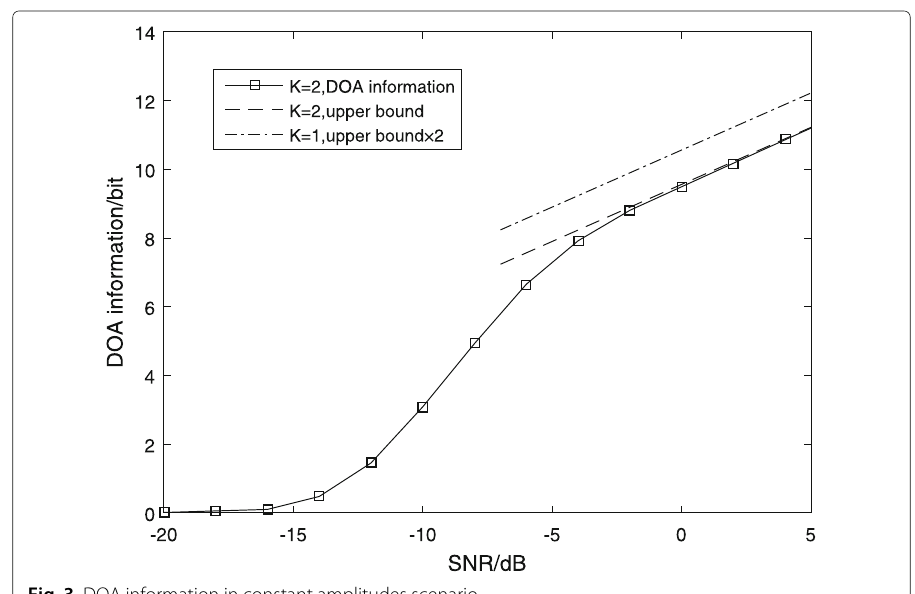
Fig. 3 DOA information in constant amplitudes scenario